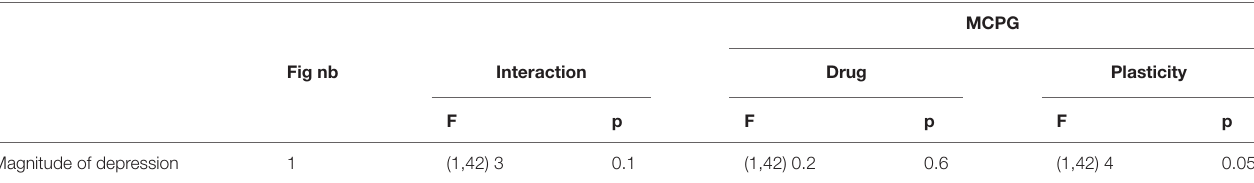
MCPG Fig nb Interaction Drug Plasticity F p F p F p Magnitude of depression 1 (1,42) 3 0.1 (1,42) 0.2 0.6 (1,42) 4 0.05 The numbers into brackets correspond to the degrees of freedom. Fig nb: number of the corresponding